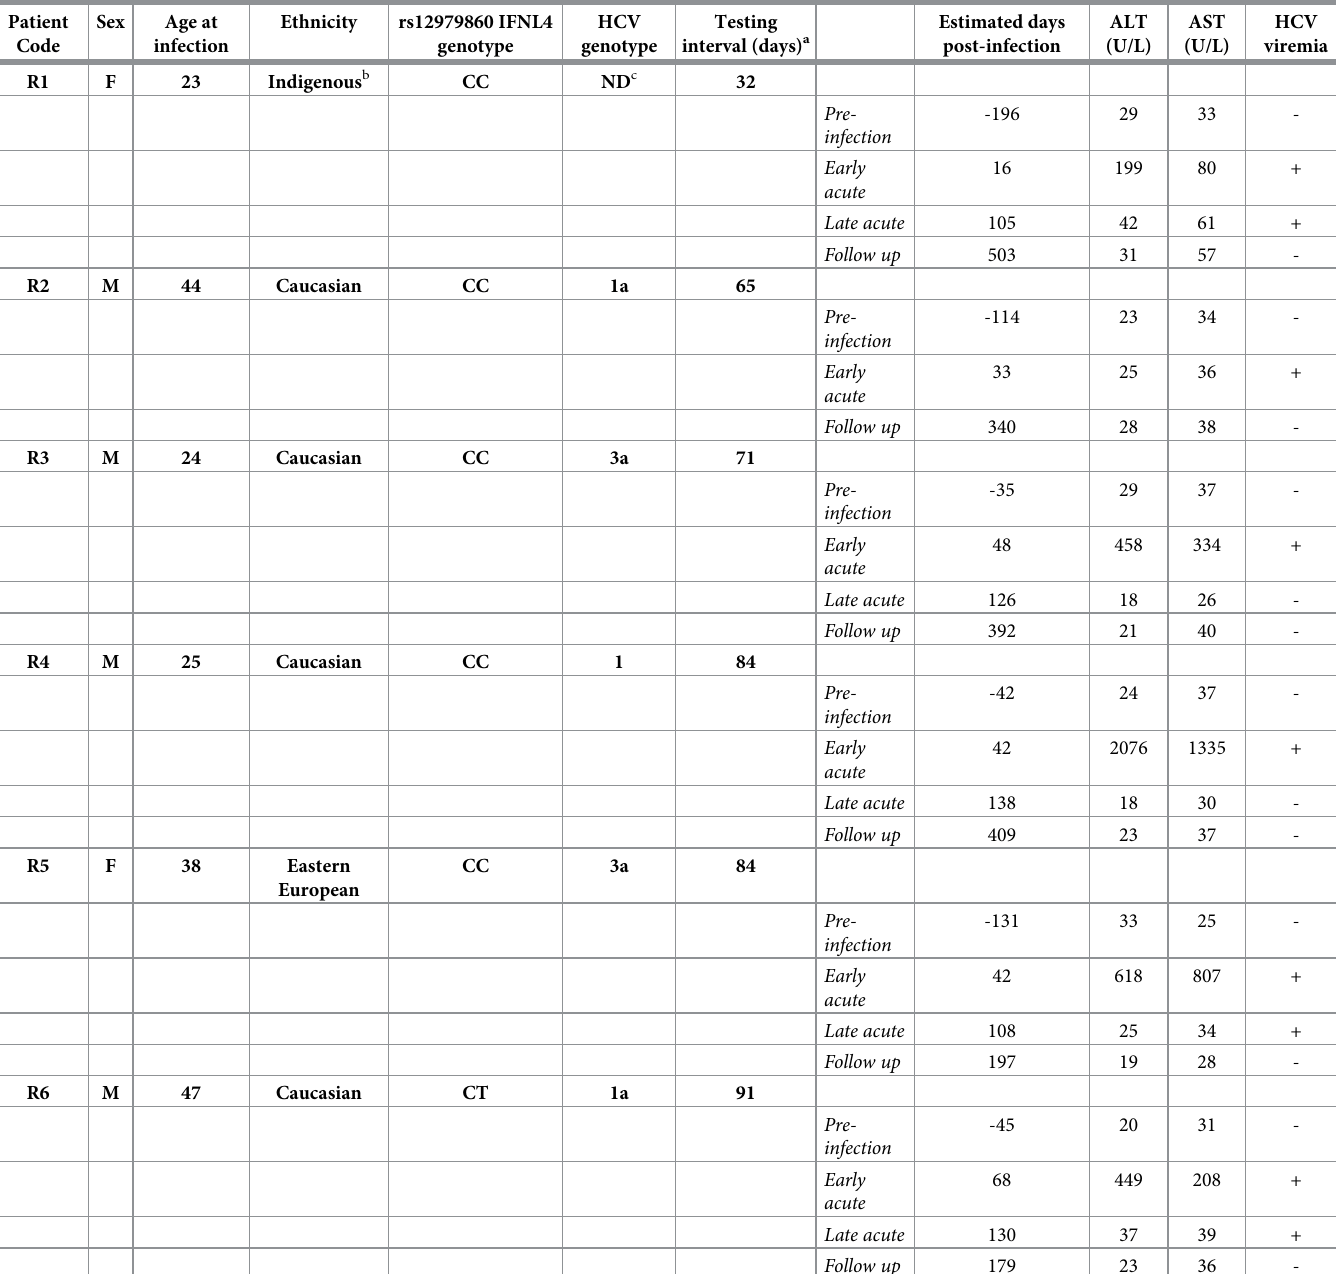
Table 1. Patient demographics and clinical information for samples analyzed by RNA-Seq: Resolution group. Patient